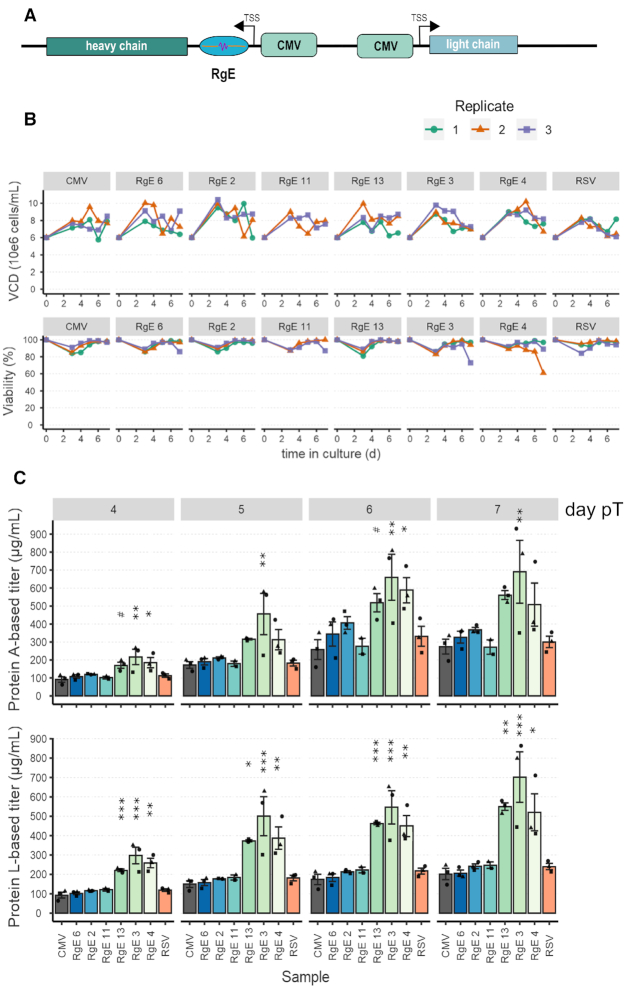
Using RgEs to tune HC expression levels to optimize recombinant production of an IgG. (A) Schematic overview of the expression construct. (B) Viable cell densities (VCD) and viabilities (%) of the transfected ExpiCHO™ cells (n = 3 independent samples each; RgE 11: n = 2). Columns represent different RgE constructs introduced. (C) Measured IgG titers on different days post transfection (pT) by either protein A- (top) or L-based (bottom) sensors. Samples are ordered by decreasing expression strength of the HC (n = 3 independent samples each; RgE 11: n = 2). Shapes of the data points indicate the respective replicates as depicted by the shapes in (B).